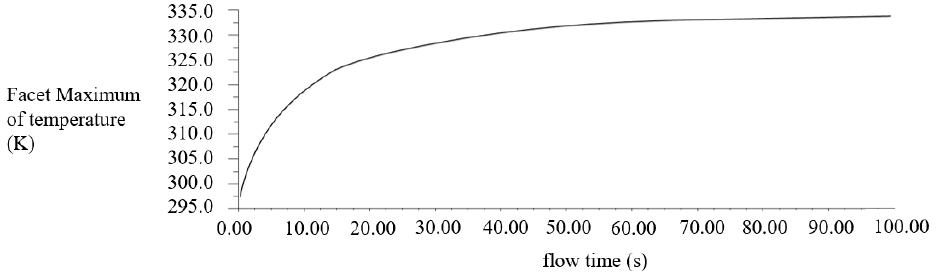
Figure 9. The maximum temperature of the heat-loaded surface of the entrance collimator varying with the pulse length.